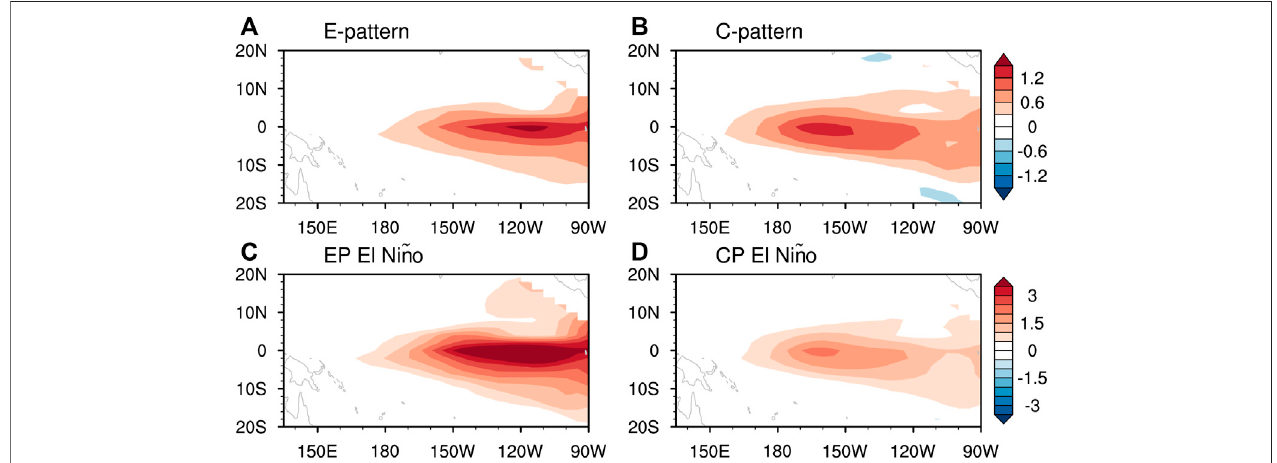
FIGURE 15 | Regressed SSTA pattern against the November-December-January average (A) E-index and (B) C-index. See text for the de fi nition of the indices. (C,D) Composites of SSTA pattern associated with EP El Niño and CP El Niño. The two types of El Niño are identi fi ed with the E-index and C-index exceeding their respective one standard deviation.